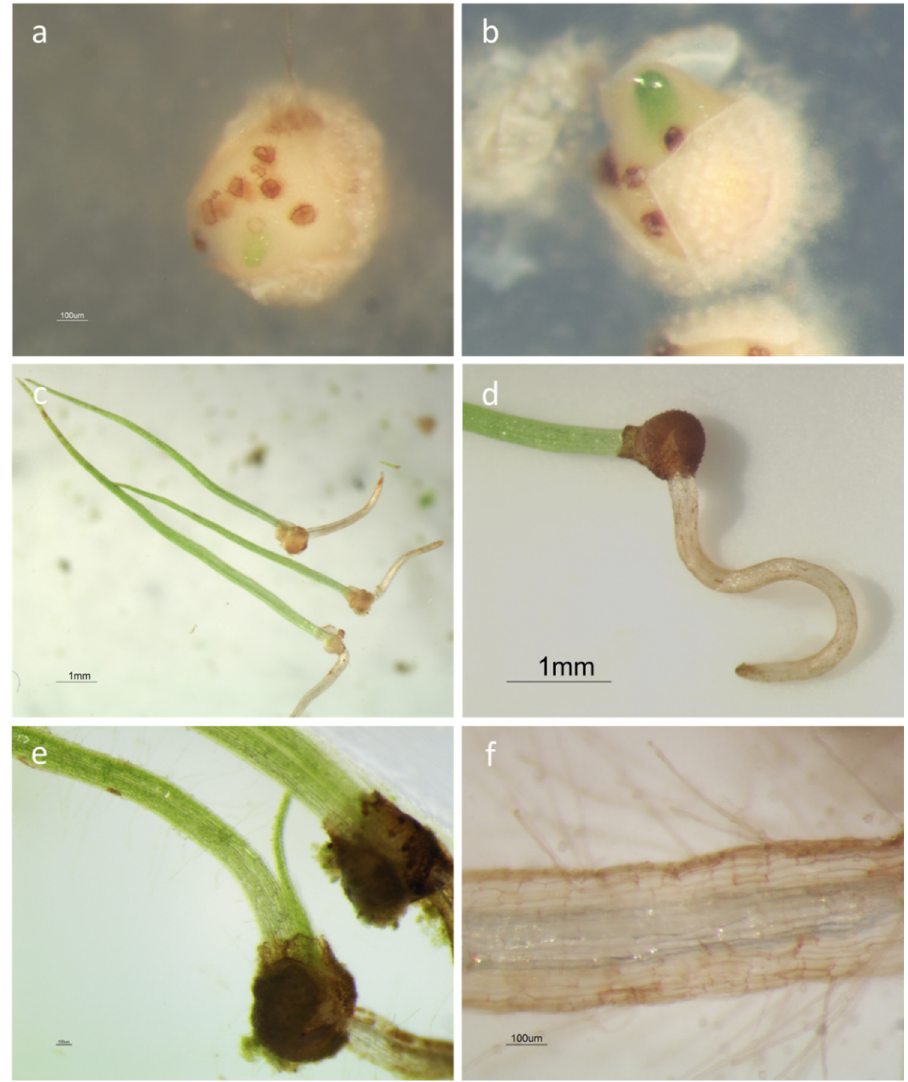
Figure 3. Sporophyte development from mixed spore cultures of Isoëtes sabatina : ( a ) the first stage of embryo development with the green apex of the primary leaf emerging from the megagametophyte; ( b ) the primary leaf protruding out the megagametophyte still enclosed within a large calyptra; ( c ) 20-day sporelings with the first leaves (7–10 mm) and roots (2–3 mm); ( d ) enlarged view, with the first leaf emerging from the calyptra and a root; ( e ) emergence of the second leaf from 35-day sporelings; ( f ) particular of a root bearing numerous root hairs; the central cavity is evident. Table 2. Indices for the evaluation of sporeling emergence from mature and immature megaspores of Isoëtes sabatina in water-agar cultures. SE: sporeling emergence percentage, calculated for the total number of sown megaspores; SE G : sporeling emergence percentage, calculated on the total number of the germinated megaspores; T 1 : time for first sporeling emergence; MDE: mean daily emergence; MET: mean emergence time; MER: mean emergence rate; CVt: Coefficient of variation of emergence time; EI: emergence index; PV: peak value; U: uncertainty of the sporeling emergence process. All values are reported as mean ± SD; values followed by the same letter are not significantly different at the 5% level of probability, as determined by Dunn's test. Significance determined by 1-way ANOVA or Kruskal–Wallis test (SE, SE G , T 1 , MDE) and t-test (MET, MER, CVt, EI, PV, U) are reported in the last column as follows: ***: p < 0.001; **: 0.001 < p < 0.01; *: 0.01 < p < 0.05; ns: p > 0.05.